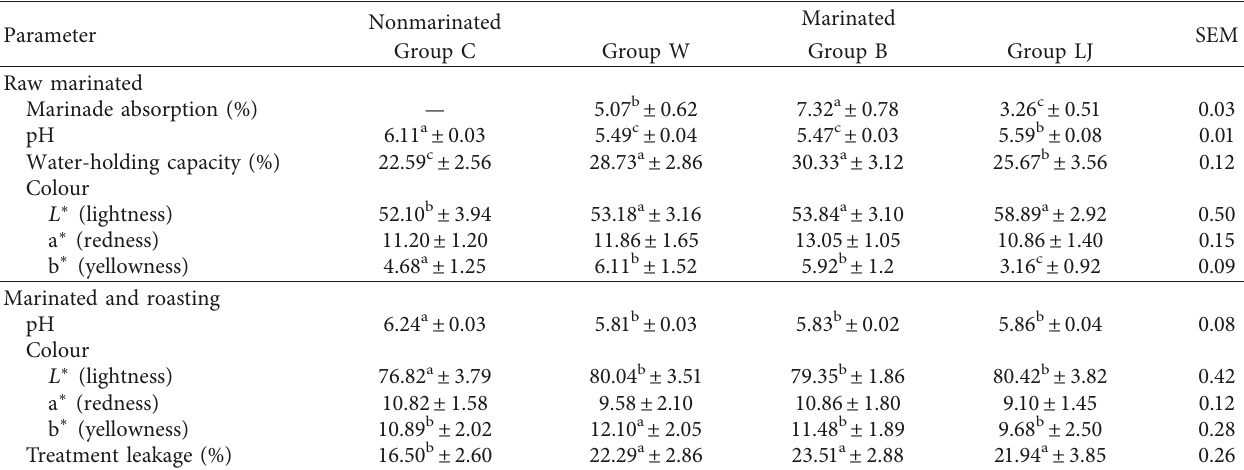
Table 1: Physical composition of nonmarinated and marinated slaughter